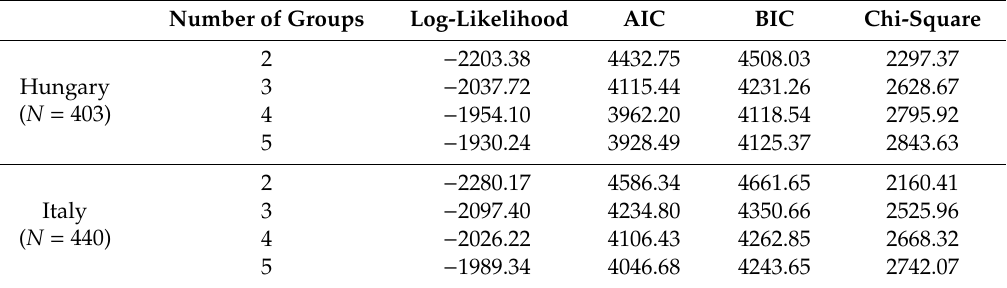
Table 5. Summary of measures for selecting the optimal number of